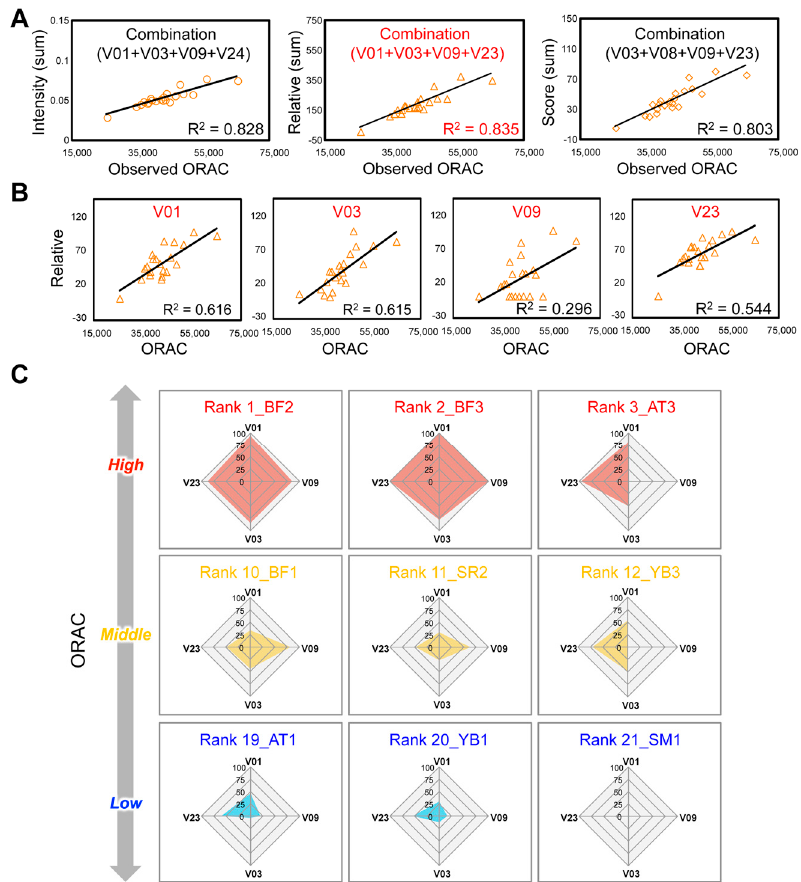
Figure 7. Chemometrics-driven selection of bioactivity-correlated chemical combinations in GTEs and visualization of observed ORAC values using the selected combination. ( A ) The highest correlation was found between the observed ORAC value and the summed abundance (Intensity) of four components as a bioactivity-predictive combination. Correlations based on the relative value (Relative: Maximum, 100; Minimum, 1) and ranked scored value (Score: Top, 21; Bottom, 1) of the summed abundances are also shown; ( B ) Correlation of the Relative value of each individual component with the ORAC; ( C ) Observed ORAC values of GTEs visualized as radar charts using information from the four selected components. Selected representative charts of the GTEs are shown, demonstrating that the ORAC can be visually estimated from the abundances of the four components. Adapted with permission from reference [117].